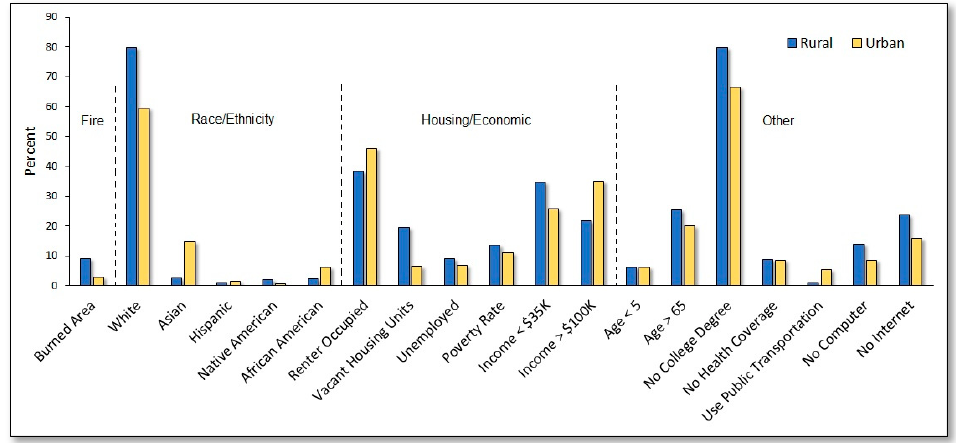
Figure 3. Wildfire vulnerability characteristics presented as percentages averaged across urban and rural Census tracts.